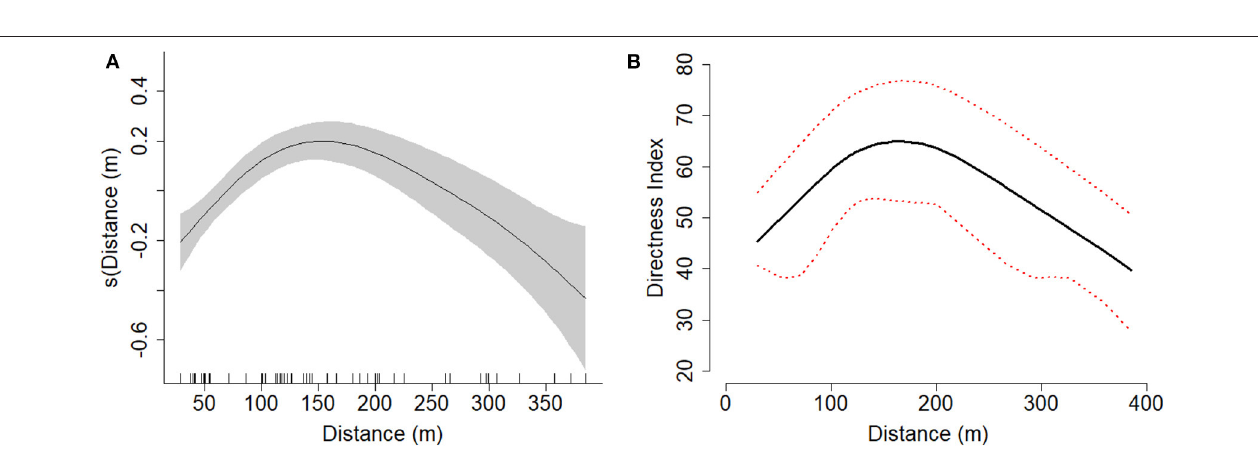
FIGURE 8 | Results from the best fit generalized additive model (GAM) for humpback whale respiration rate showing (A) model parameter estimates for encounter type (B-Before, D-During, A-After) and (B) model predicted respiration rate based upon encounter type. Dashed lines in image (A) represent the 95% confidence intervals of the parameter estimate. Vertical ticks (A) indicate the locations of observations (i.e., rugplot).